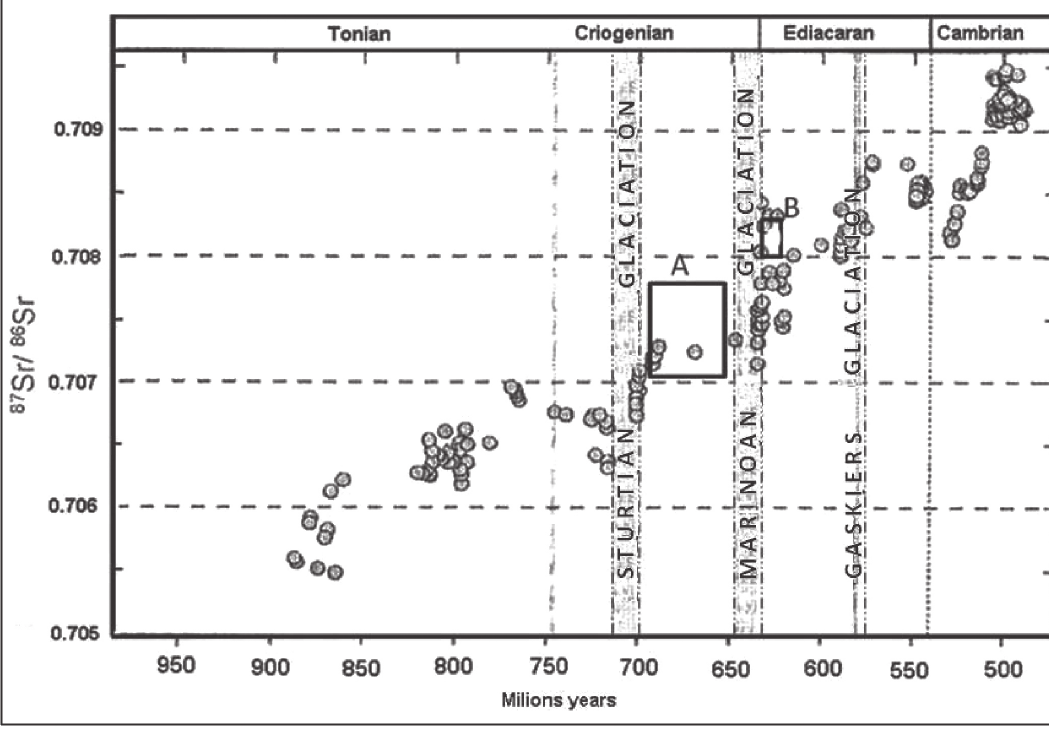
Figure 12 - Distribution of 87 Sr/ 86 Sr from carbonate rocks along the Neoproterozoic (Halverson et al. 2007). The 87 Sr/ 86 Sr data for the sections 1 and 2 (Macaúbas Group) and 3 (Rio Pardo Grande Formation) concentrate in A; while values for samples from the Bambuí Group (section 4) plot in